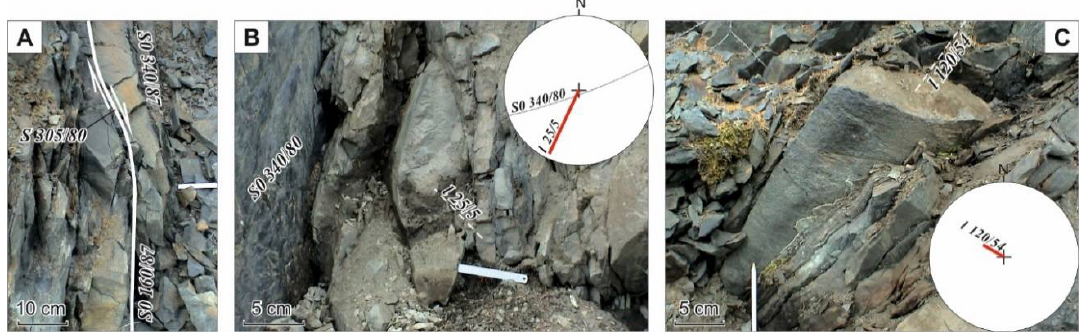
Figure 7. Dextral strike-slip fault ( A ) and boudinage-structures ( B , C ), Dvoinoy Creek.